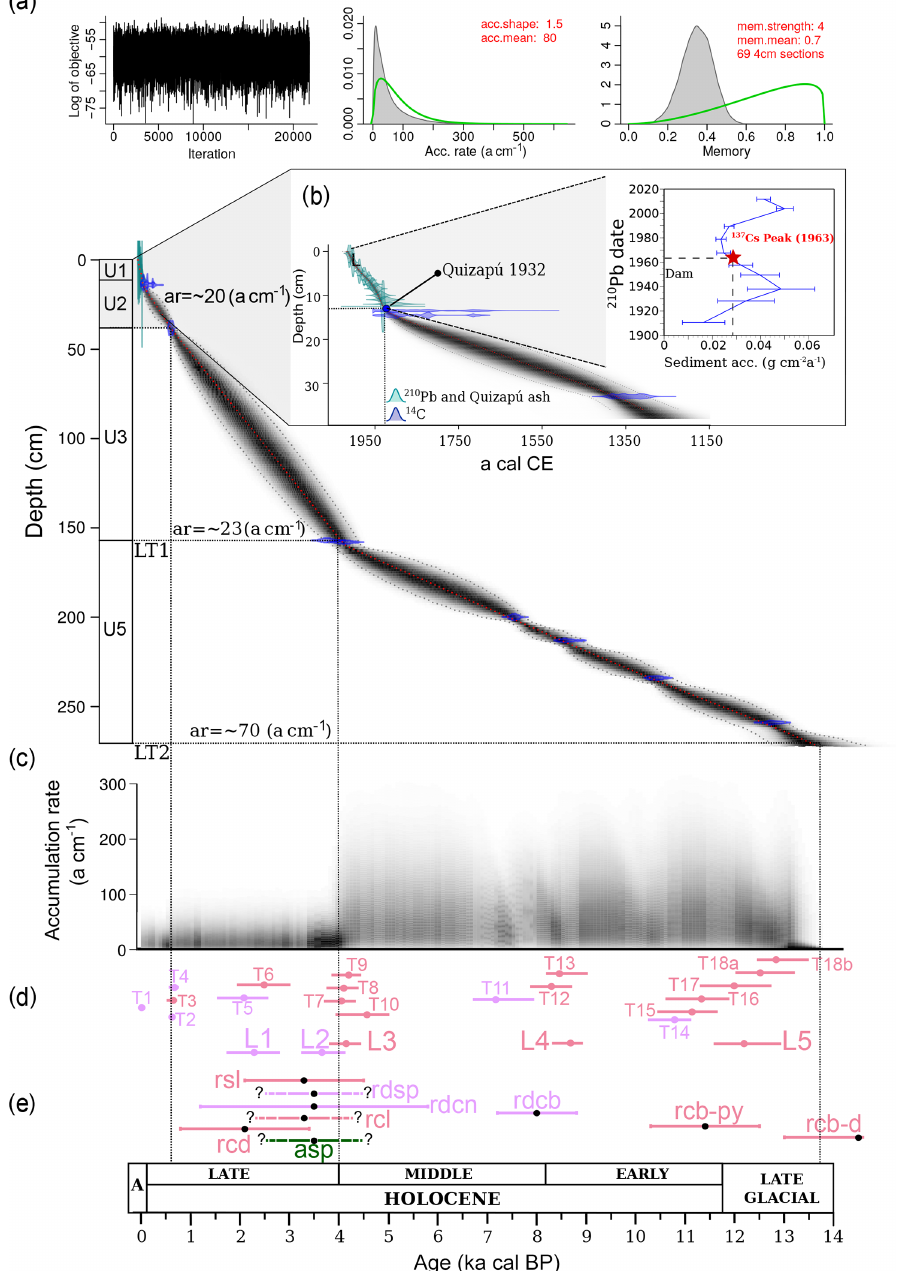
Figure 5. Bayesian chronological model for LdM sequence based on combined analyses of 210 Pb, 137 Cs and nine AMS 14 C dates. Bayesian age model of LdM showing the calibrated 14 C dates and the age–depth model (Blaauw and Christen, 2011). (a) Chronological model for the last 14.0kyr. (b) Detail of the CRS (constant rate of 210 Pb supply) model, the 1963 depth determined from 137 Cs peak (red star at 6.5–7cm) and the Quizapú ash horizon ( ∼ 14–15cm). (c) The accumulation rates (in years per centimeter) as estimated by the MCMC iterations (Blaauw and Christen, 2011) with a median of 10, 20, 23 and ∼ 70yrcm − 1 for units 1, 2, 3 and 5, respectively. (d) Schematic representation of the volcanic facies ages estimated from the chronological model for LdM. The ash and lapilli layers are color-coded according to macroscopic and microscopic features and compositional data from XRF analysis: pink – ash with higher Si and Rb and lower Fe and Sr; mauve – ash with higher Sr, Ti and Fe and lower Si and Rb; mauve – lapilli layers with MS > 200SI, higher Ca and Sr, and lower Fe and K; pink – lapilli with MS < 200SI, higher K and lower Sr, Ca and Fe. (e) Distribution of the Laguna del Maule eruptive unit ages reported by Andersen et al. (2017): pink (rhyolite), mauve (rhyodacite) and green (andesite) colors represent postglacial eruption units described in Hildreth et al. (2010), Andersen et al. (2017) and Singer et al. (2018) (see Fig. 1). Note in (d, e) the greatest number of volcanic events during the late glacial period–Early Holocene and Middle–Late Holocene